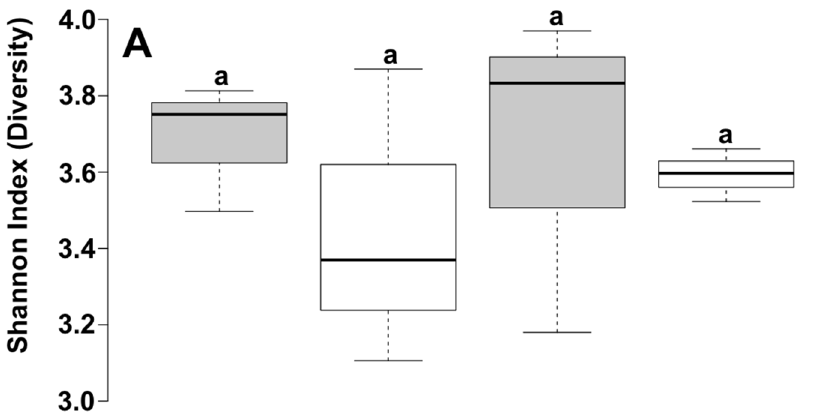
Figure 2. Boxplots of the Shannon’s index and richness of observed T-RFs for mangrove bacterial communities in four depths. Center lines show the medians; box limits indicates the 25th and 75th percentiles as determined by R software; whiskers extend 1.5 times the interquartile range from the 25th and 75th percentiles. Significant differences among sediment depths are indicated by different letters according to the performed ANOVA and Tukey HSD test ( p <